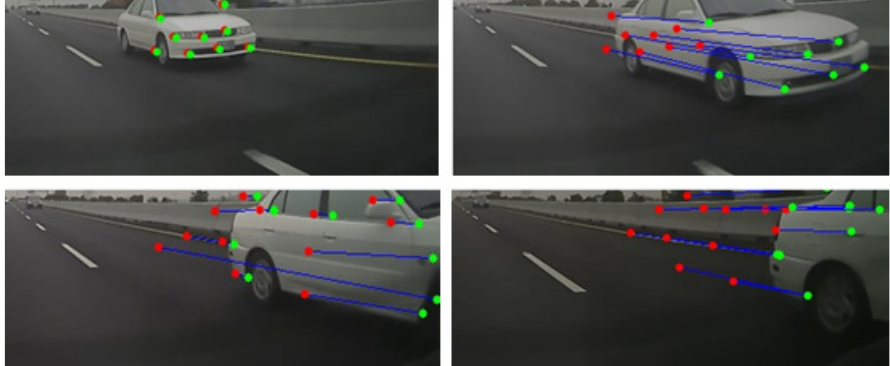
Figure 12. Overtaking tracking diagram. The red point is the initial position, and the green point is the current position. The blue line is the corresponding